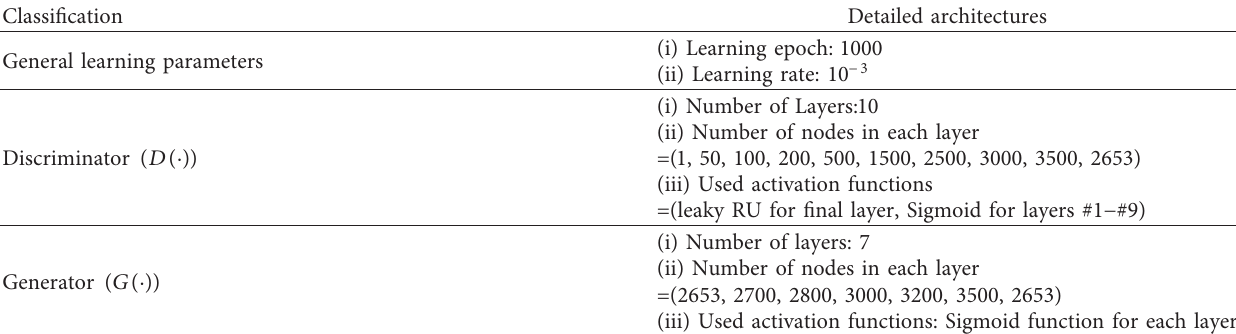
Table 8: Detailed architecture and relevant parameters of the GAN-based RUL estimation (case for fault code ID